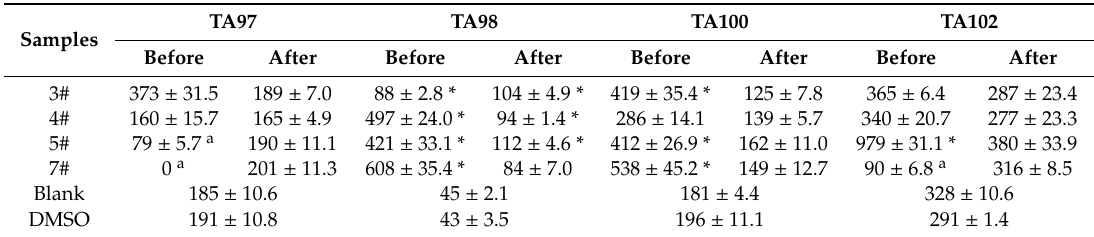
Table 5. Reverse mutation colonies of four strains detected by overlying water extracts before and after remediation.